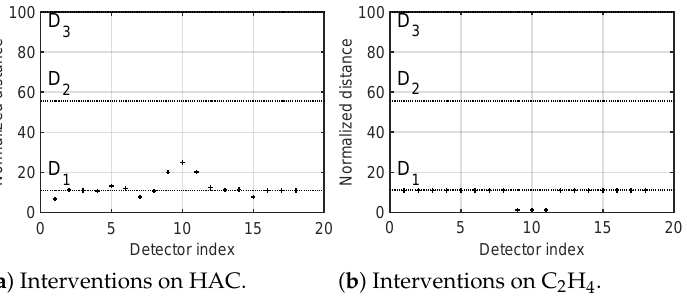
Figure 12. Computed mass function of each detector in the case of two interventions.